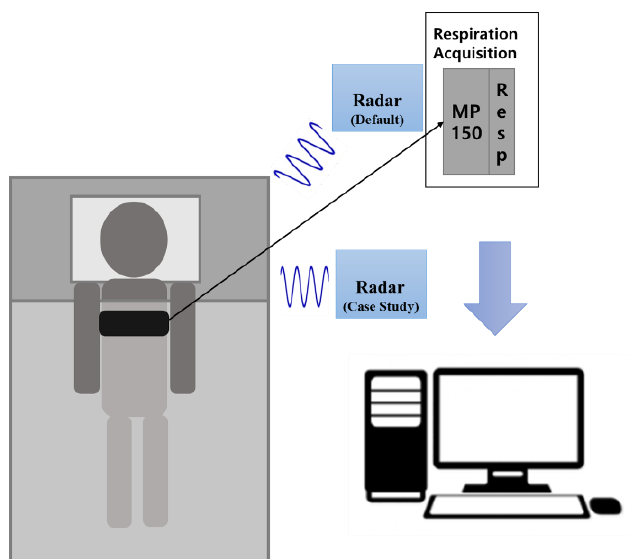
Figure 1. Experimental setup.